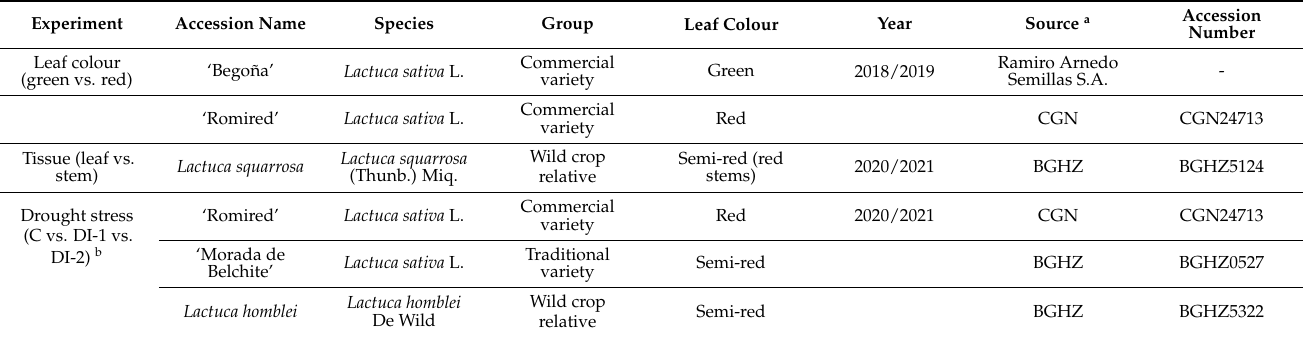
Table 5. Plant material used in the three experiments of the present